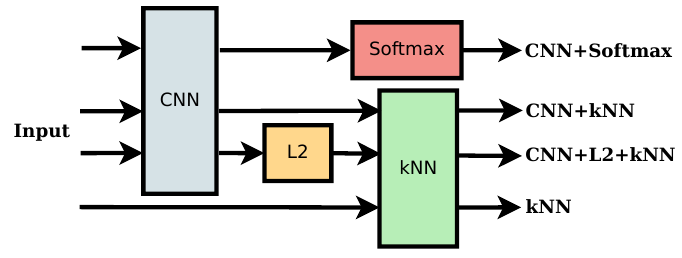
Figure 1. Scheme of the four configurations evaluated.